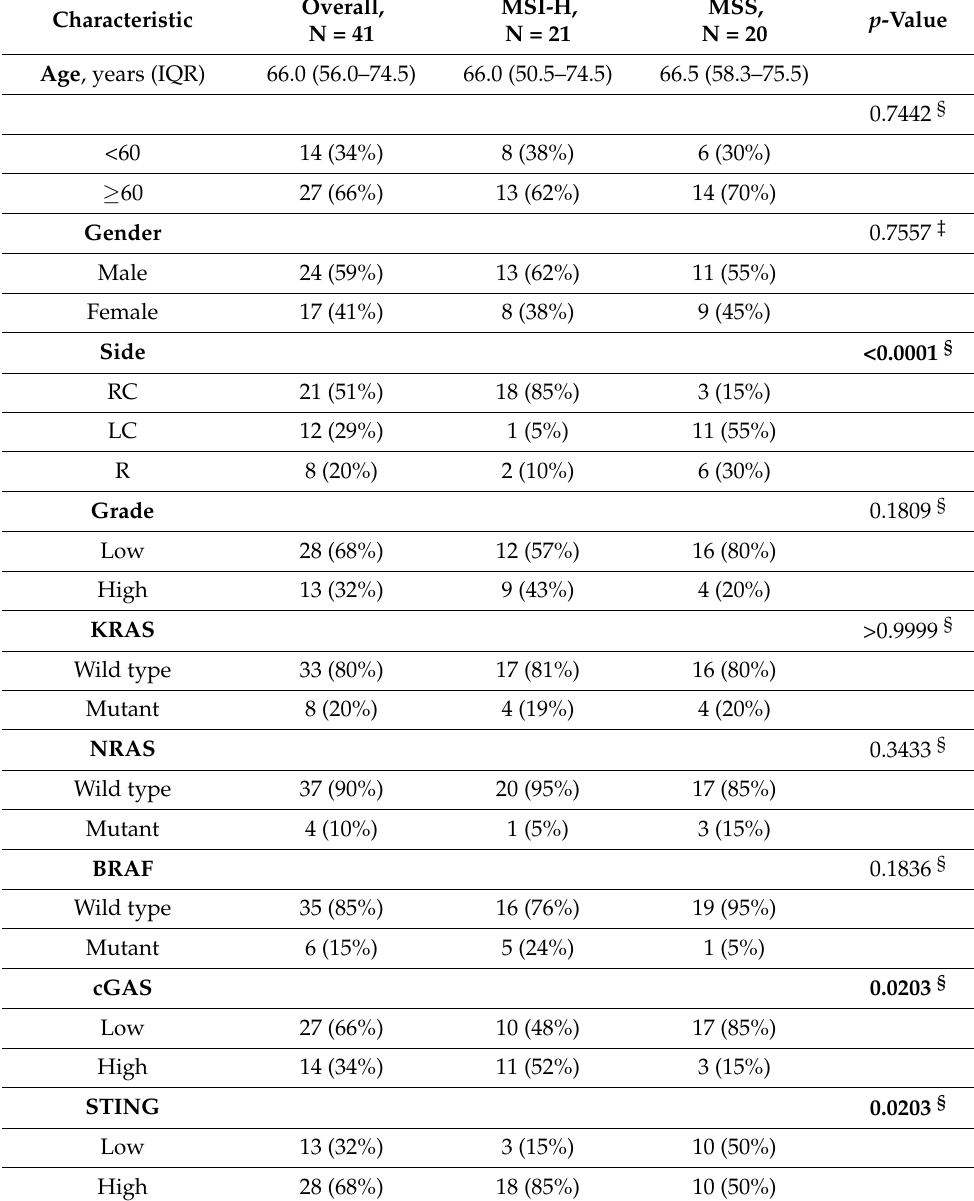
Table 1. Clinicopathological characteristics of patients with stage IV